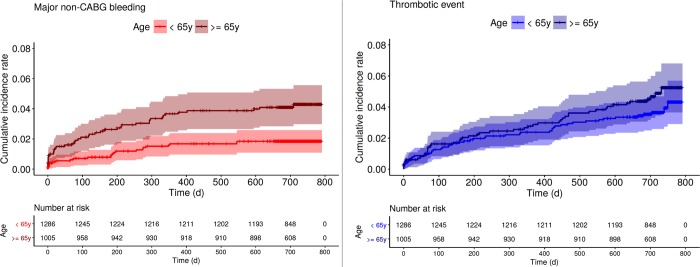
Cumulative incidence curves with 95% confidence bands for the competing events of non-CABG major bleeding (Fig 4A) and thrombotic event (Fig 4B) according to age dichotomized at 65 years. Note the significant differences in major bleedings indicated by the not overlapping confidence bands, but the non-significant differences in thrombotic events. CABG, coronary artery bypass graft.